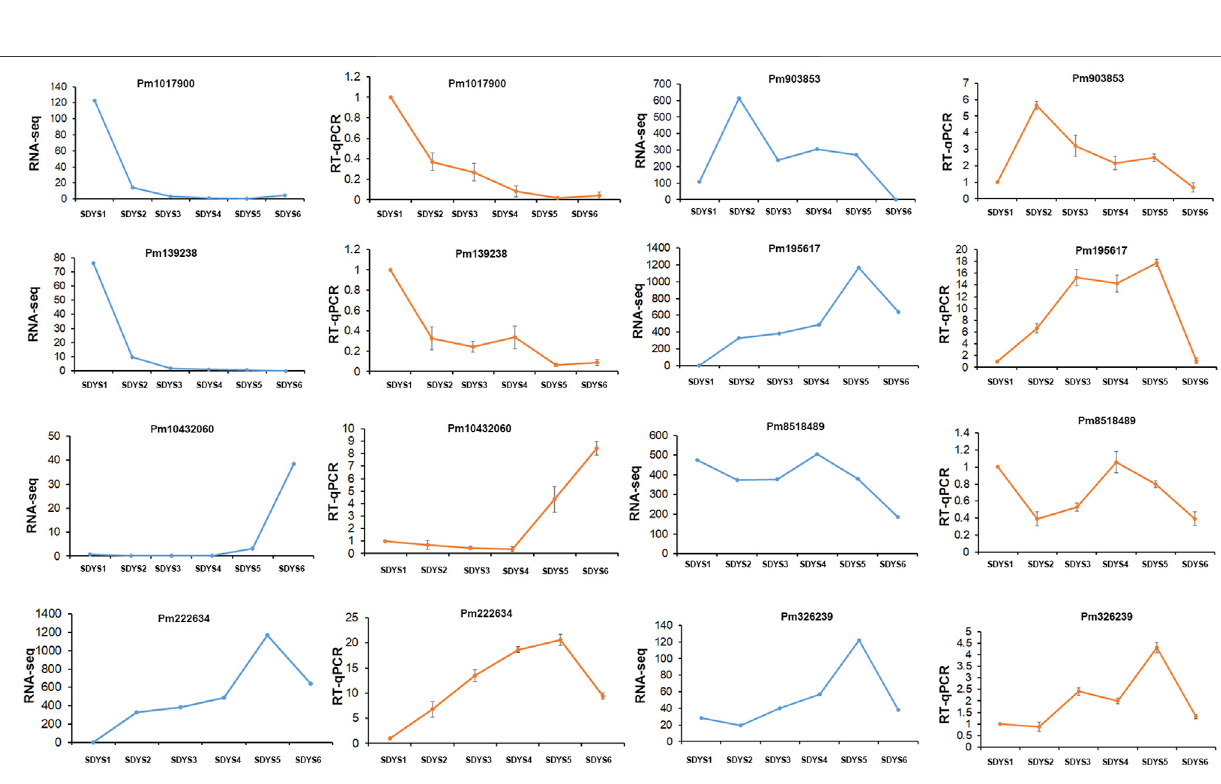
Frontiers in Genetics |